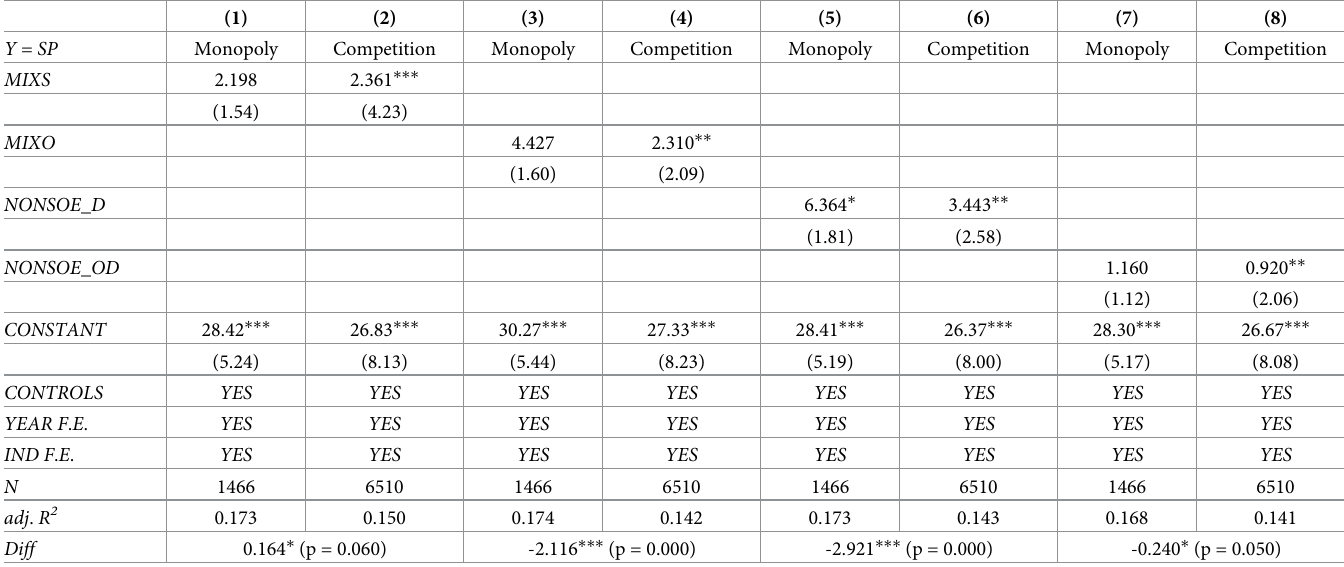
Table 13. The group inspection results of industry